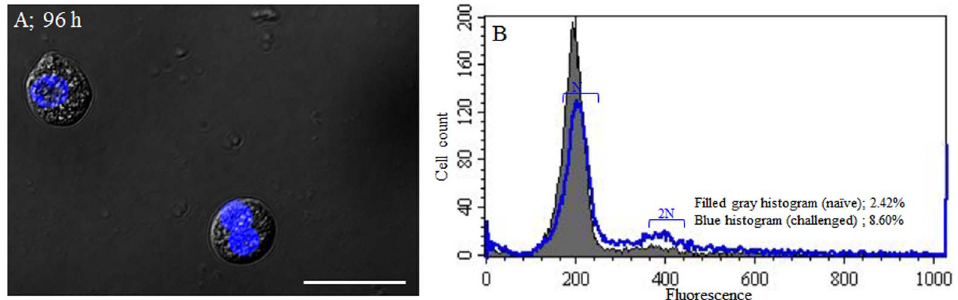
Figure 8. Granulocyte mitosis induced by non-florescent carboxyl modified beads injection into the hemocoel. (A) Analysis by DIC and fluorescent microscopes showed that the granulocytes were mitotically divided at 96 h post injection. (B) Flow cytometric analysis of granulocyte mitosis. Shown are representative histogram overlays: filled histogram (0 h injection) and blue transparent histogram (96 h post injection). 2.42% of hemocytes in naı¨ve larva were undergoing mitosis, compared to 8.60% of hemocytes in challenged larvae at 96 h post injection.